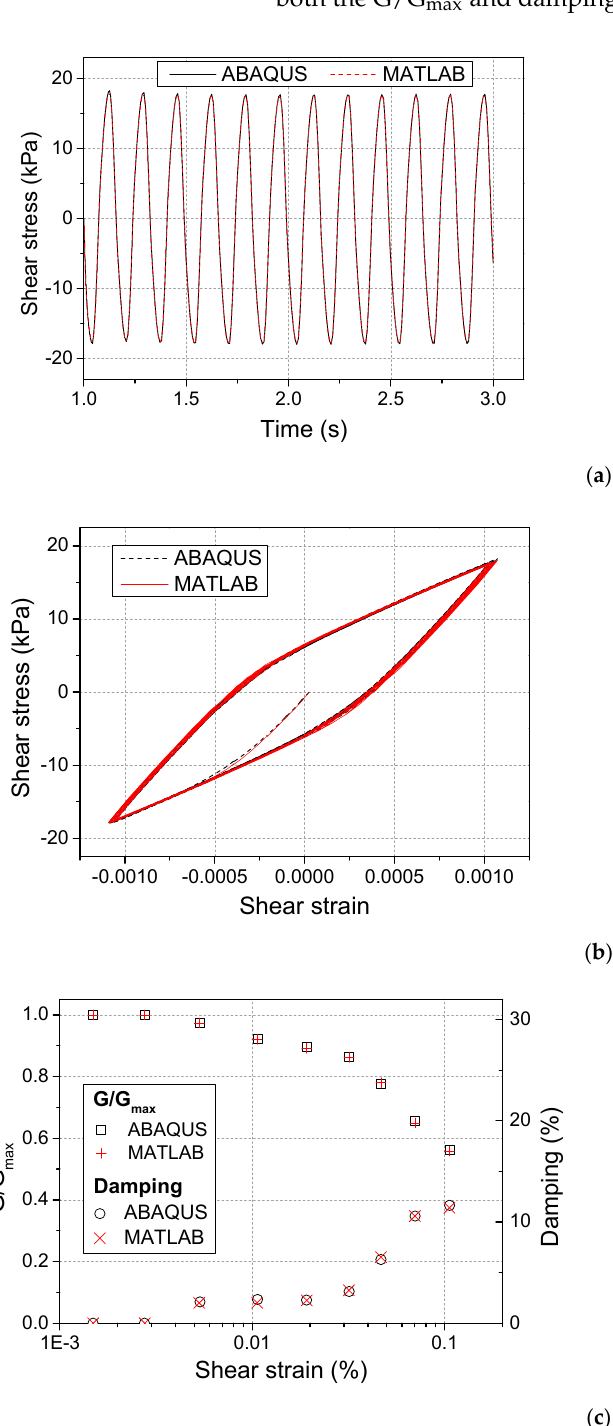
Figure 6. Comparison of ( a ) shear stress estimation, ( b ) shear stress–shear strain hysteretic loop, and ( c ) G/G max and damping curves between ABAQUS and MATLAB typically for silica sand ( left ) and Toyoura sand ( right ).